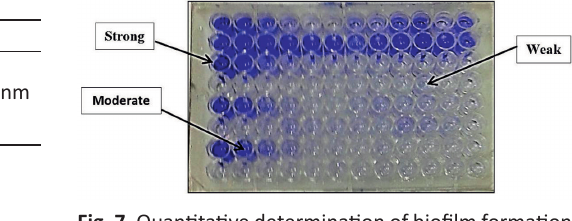
Table 7. Anti-biofilm effect of Z. spina-christi total extract on P. aeruginosa